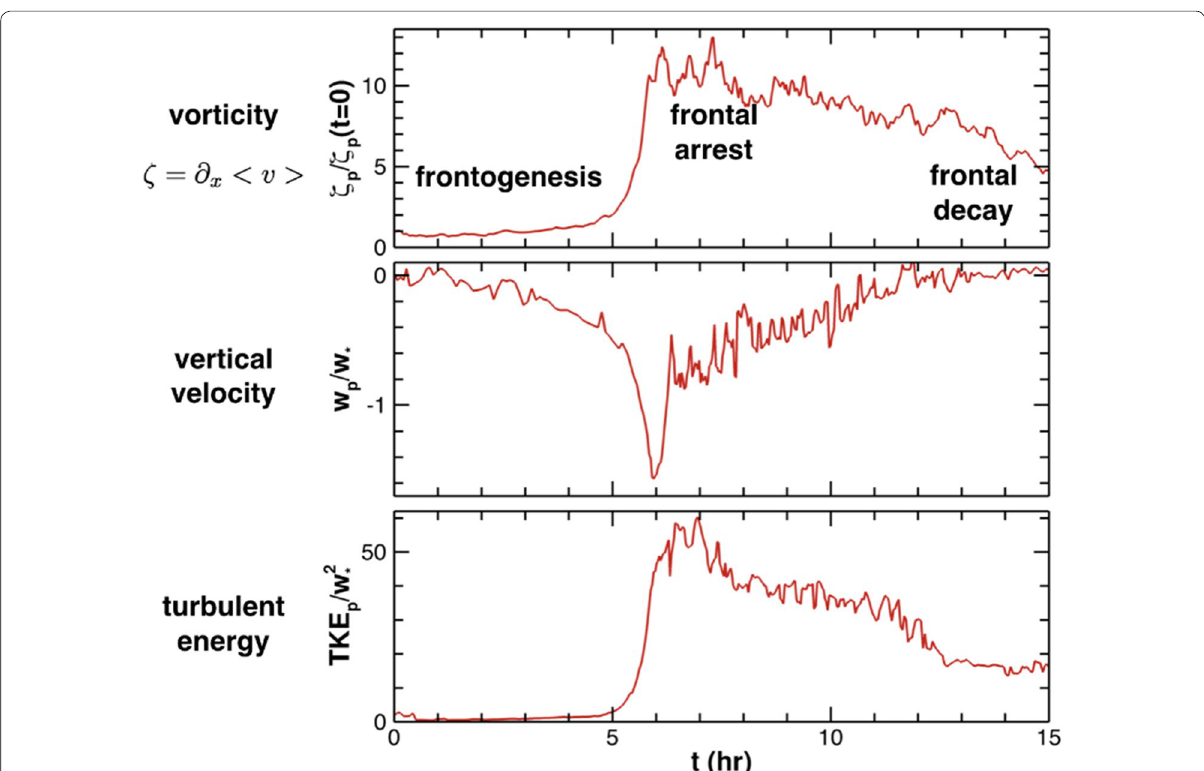
Fig. 11 Filament life-cycle. The associated time series for peak values of the along-front averaged fields in the middle of the filament: peak vorticity normalized by the initial value (top), peak downwelling velocity normalized by the surface cooling scale w ∗ (middle), and peak turbulent kinetic energy normalized by w 2 ∗ . This is for the same simulation as in Fig. 9 (Sullivan and McWilliams